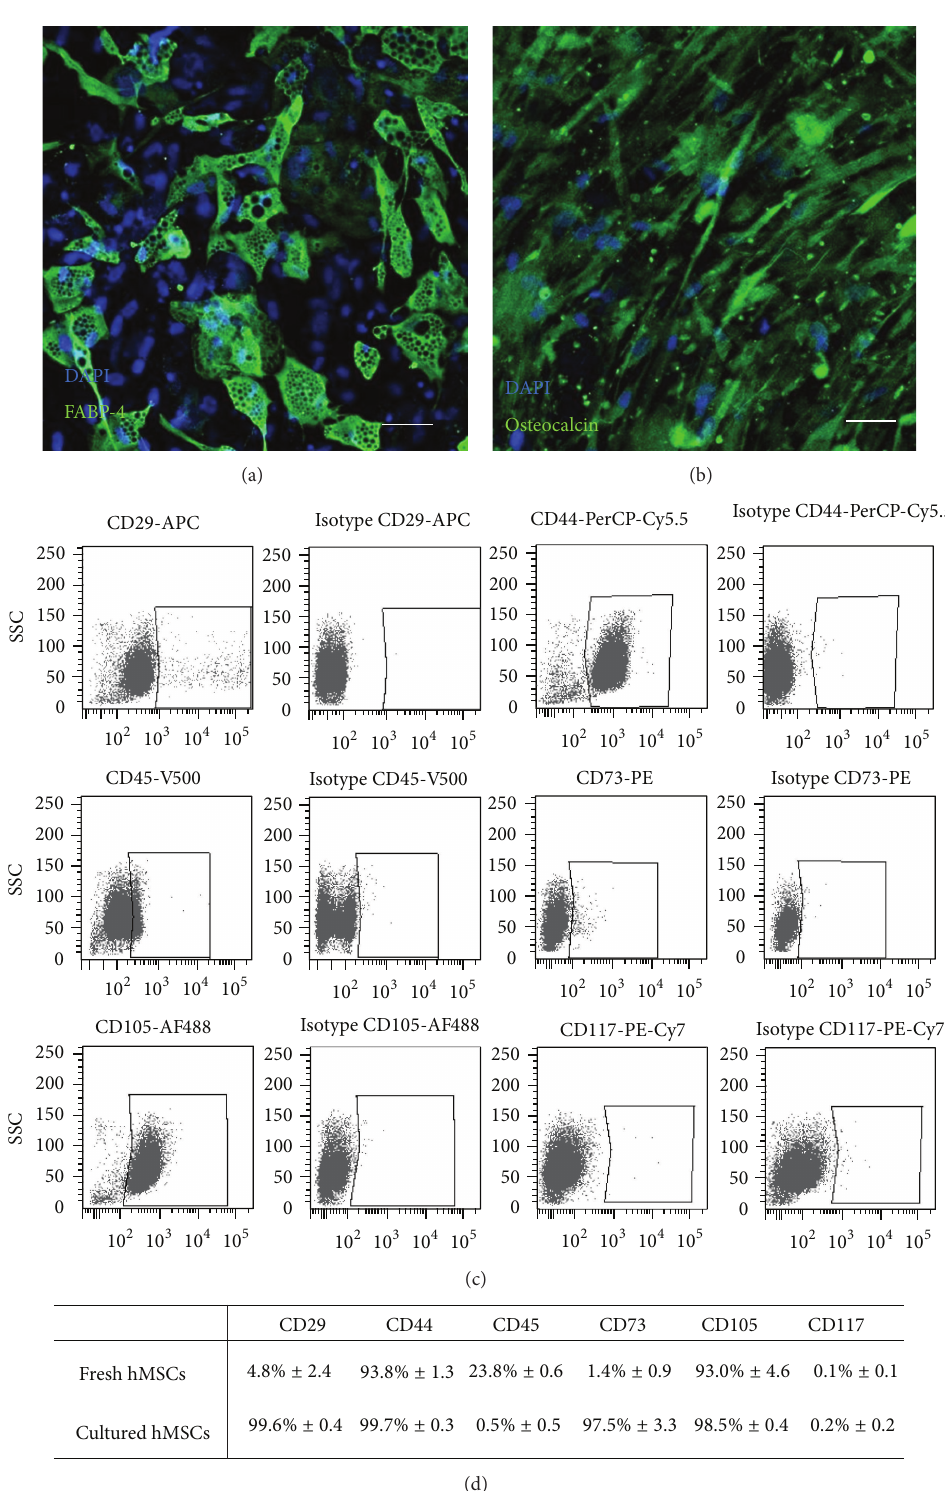
Figure 1: Characterization of CD105 + hMSCs. ((a), (b)) Functional differentiation capacity of freshly isolated CD105 + cells was shown by immunostaining of FABP-4 (green) for adipocytes (a) and osteocalcin (green) for osteocytes (b) after 20 days in appropriate differentiation medium. Nuclei were counter stained with DAPI (blue). Scale bars = 50 𝜇 m. ((c), (d)) Immunophenotyping of freshly isolated ((c), (d)) and cultured CD105 + hMSCs (d) was evaluated by flow cytometry after staining of specific cell surface markers. Corresponding isotype controls were used as negative controls (c). The relative expression values of CD marker expression are shown as mean ± SD; 𝑛 = 2